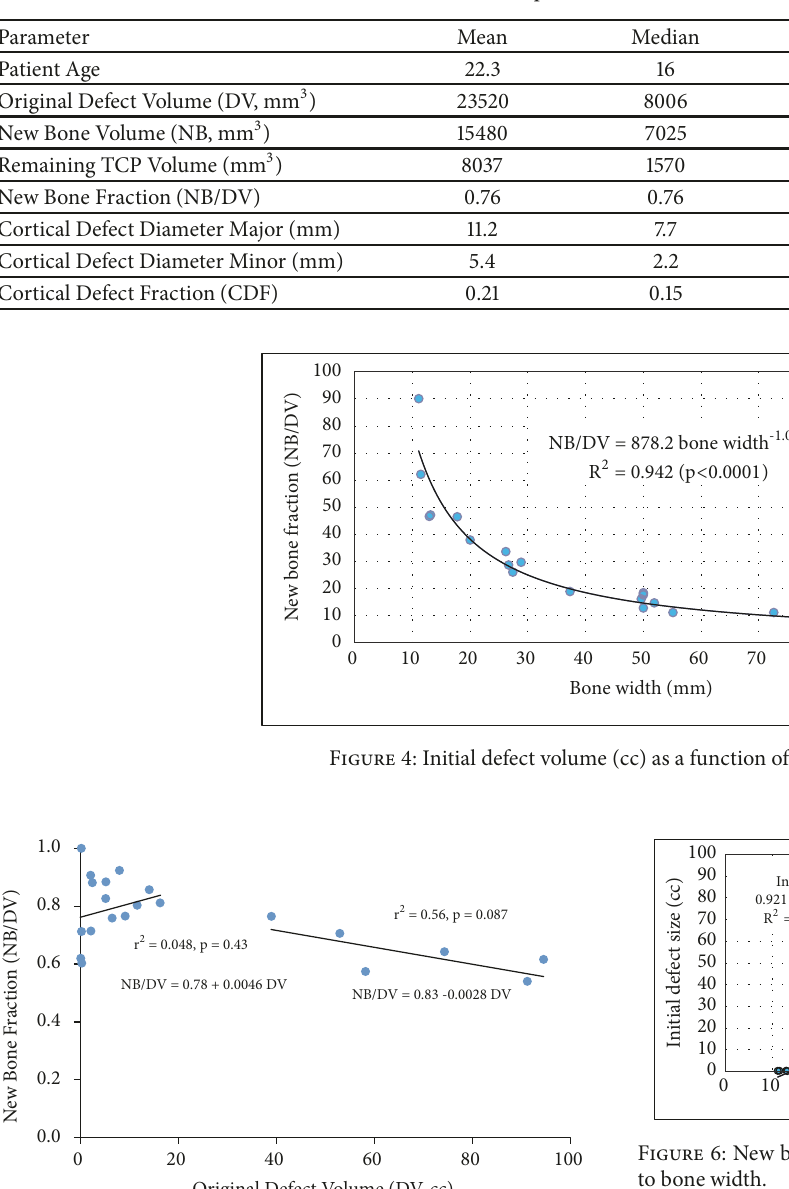
Table 1: Descriptive statistics for 21 bone lesions.